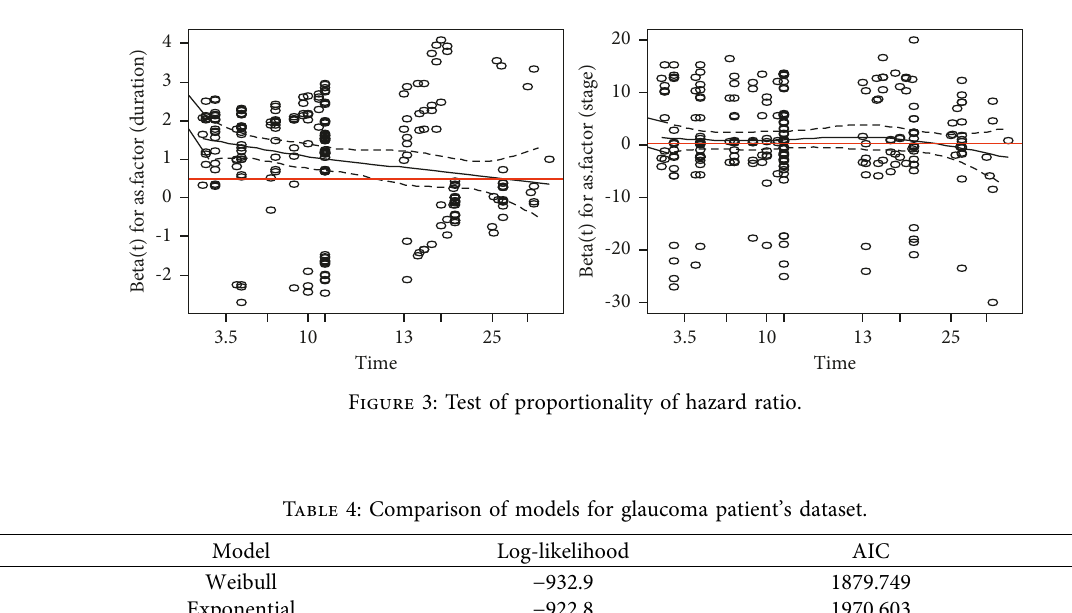
Table 5: Multivariable analysis of glaucoma patient’s dataset at Jimma University specialized hospital, 2016–2020 ( n � 321).